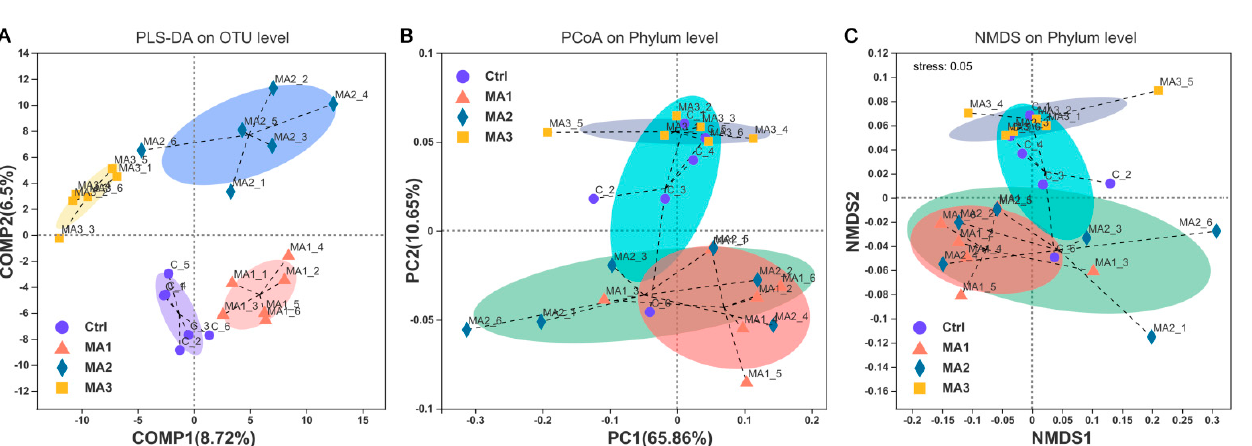
Figure 2. The β − diversity of cecal microbiota of broilers. ( A ) Partial least squares discriminant analysis (PLS-DA) on operational taxonomic unit (OTU) level. ( B ) Principal coordinate analysis (PCoA) of weighted distance calculated from phylum abundance matrix. ( C ) Nonmetric multidimensional scaling (NMDS) on phylum level. Ctrl: the control group; MA 1–3: the experimental groups fed the basal diets supplemented with 4, 8, and 12 g/kg of bio-fermented malic acid, respectively.